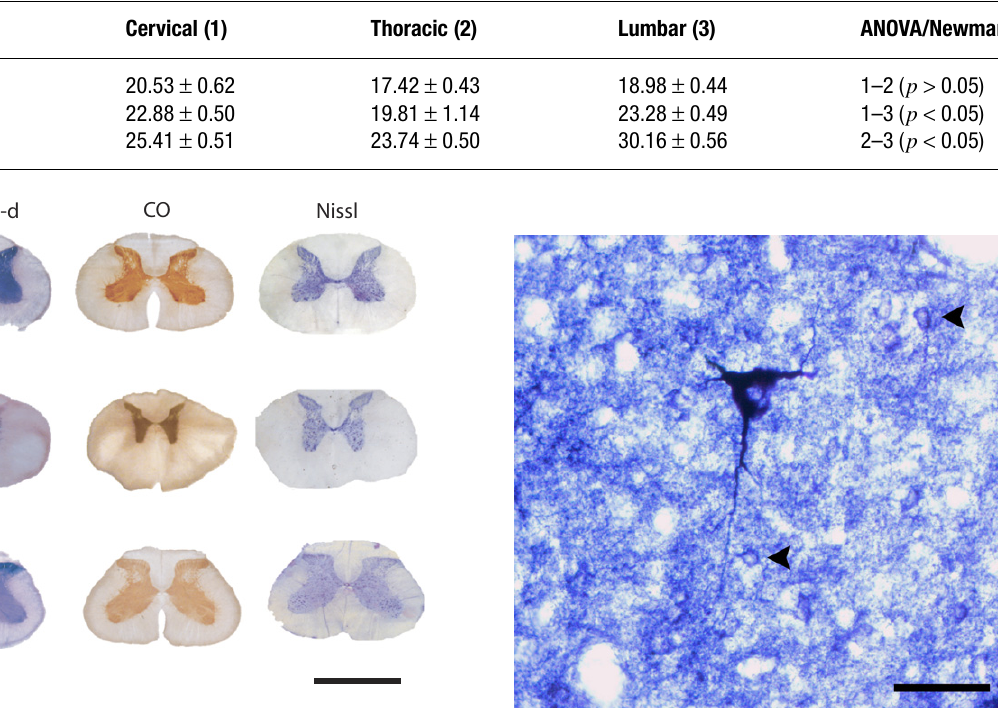
Figure 1. NADPH diaphorase and cytochrome oxidase reactivity in coro- nal sections of the agouti’s spinal cord. The enzymatic reaction pattern is Figure 2. Comparative morphology of types I and II neurons in the cen-